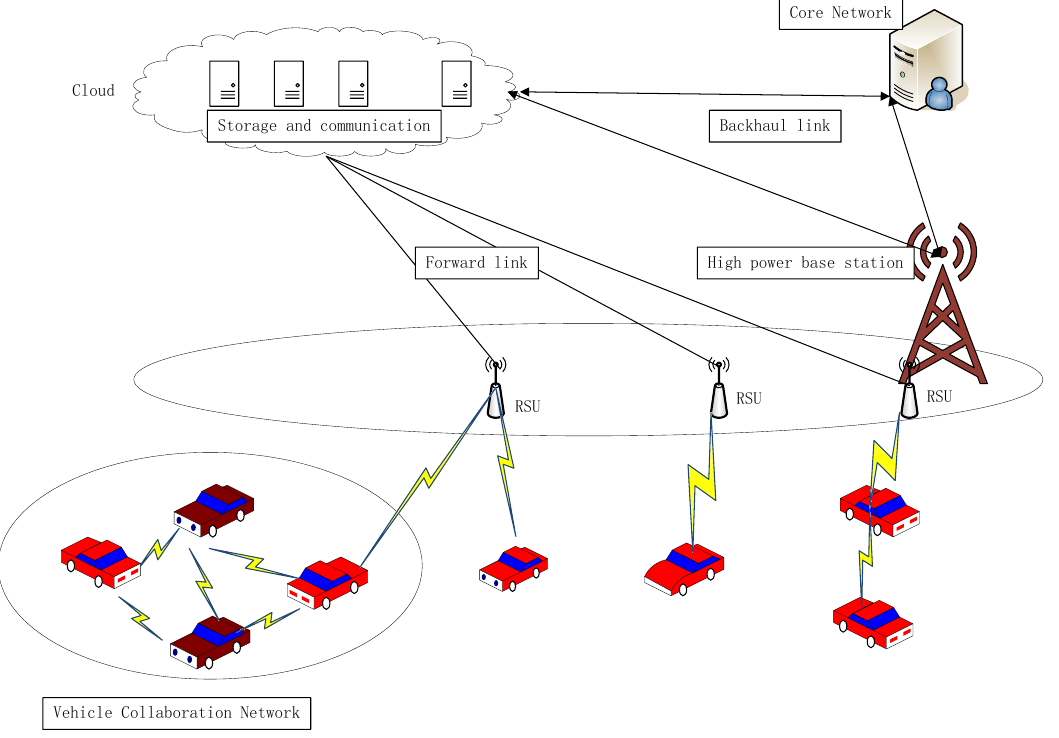
Figure 1 The architecture of vehicular fog computing. Figure 1. The architecture of vehicular fog